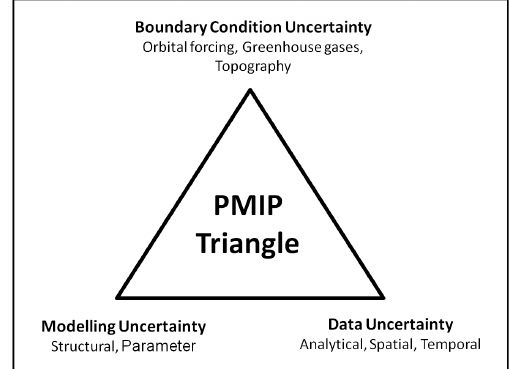
Figure 1. The PMIP triangle which illustrates three possible con- tributions to data–model discrepancy, and it has at its vertex model physics (structural and parameter uncertainty), model boundary conditions and proxy data uncertainty (Haywood et al.,